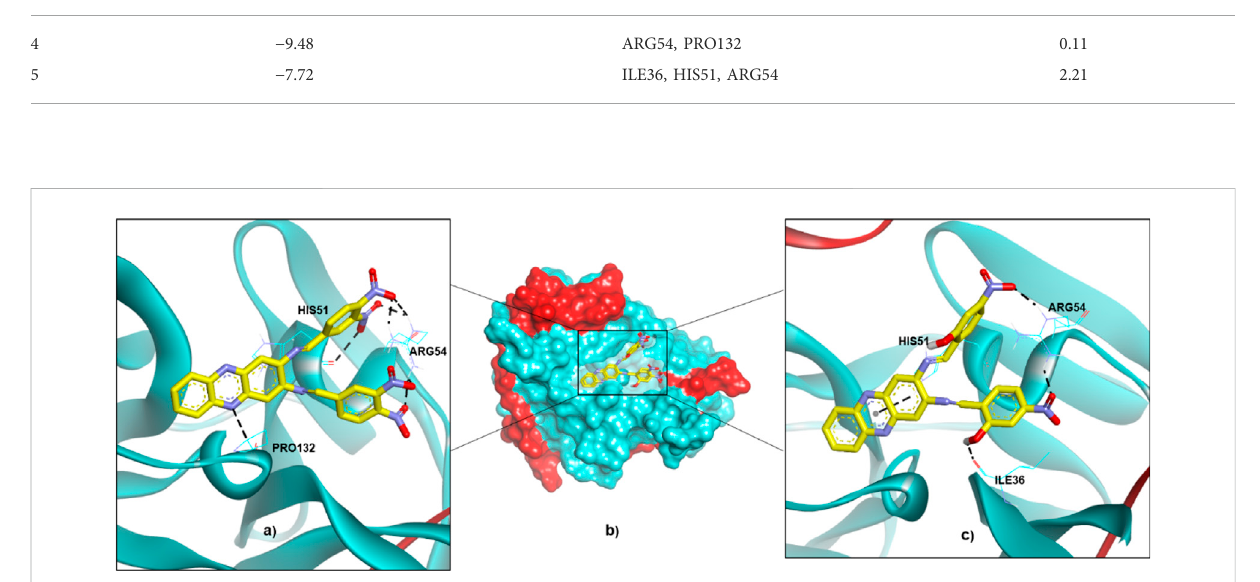
Frontiers in Molecular